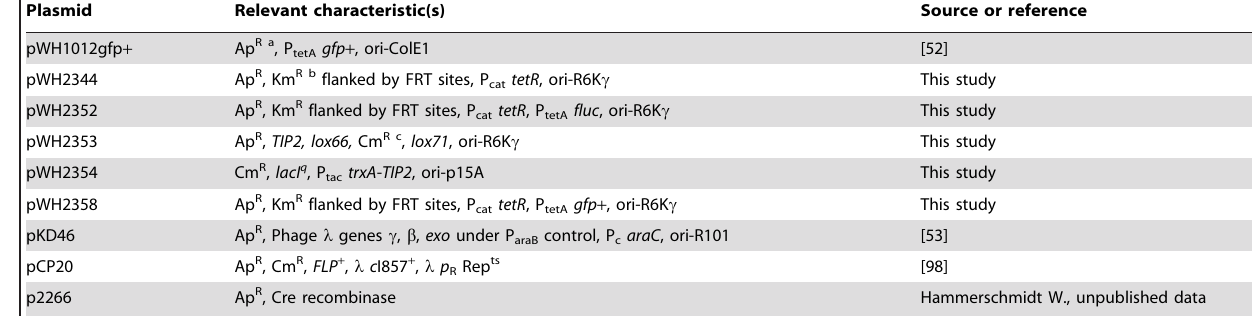
Plasmid Relevant